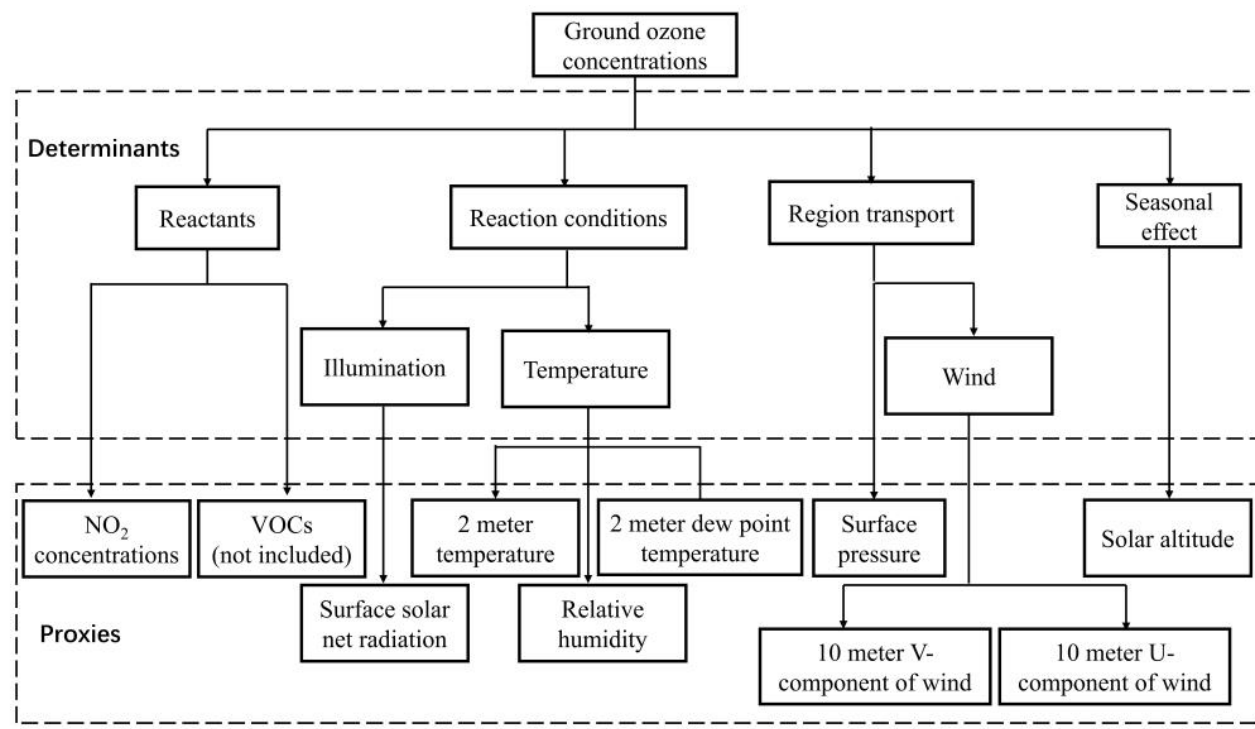
Figure 1. The detailed parameters from ERA5 land reanalysis data and observation stations are listed in Table S1.